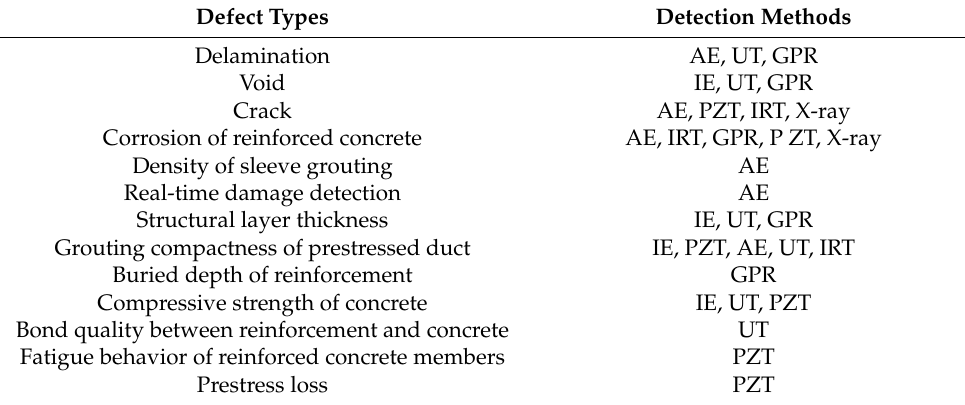
Table 2. Common testing methods for different